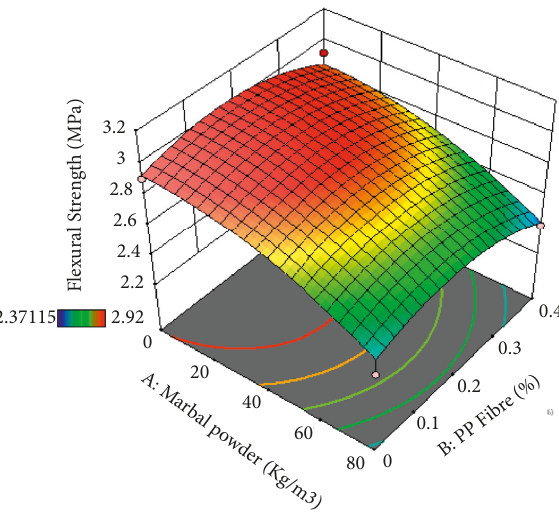
Figure 10: Flexural strength development.